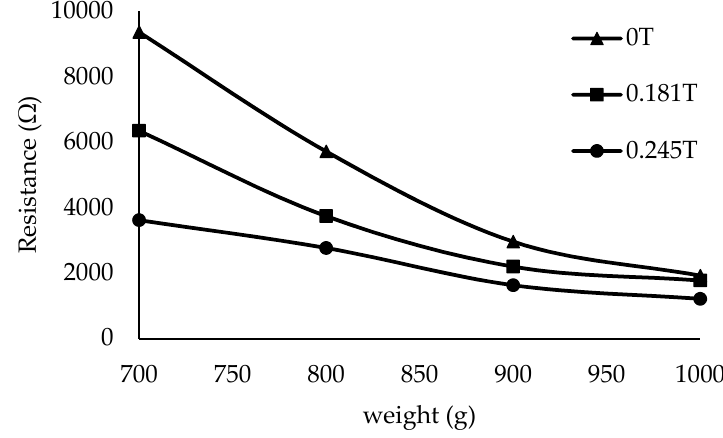
Figure 11. Resistance reduction of MRE samples with graphite content at magnetic fields of 0, 0.181, and 0.245 T.